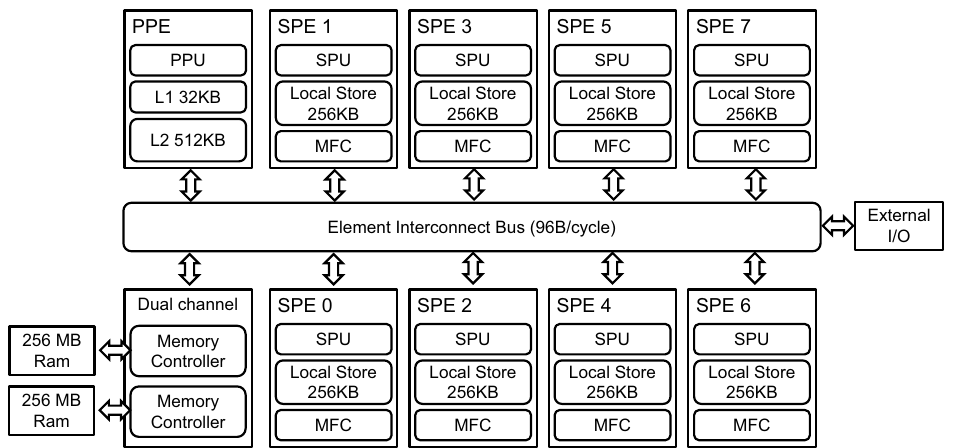
Figure 1. The block diagram of the Cell BE